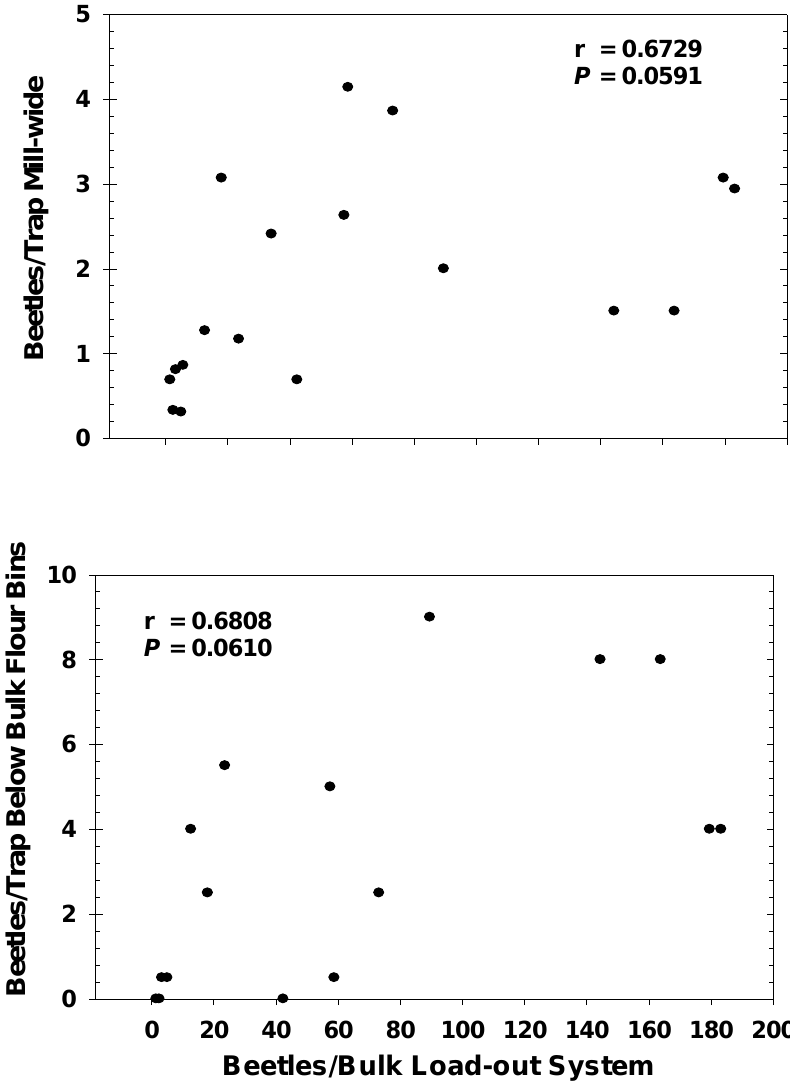
Figure 7. Correlations (r, with significance of the correlation analysis, P ) of T. castaneum trapped in mill 1 to those sampled from bulk load-out tail-overs during Year 2. Results are from 18 weekly observations from 16 modified pitfall traps (mill-wide data, top graph) and 2 modified pitfall traps (below bulk flour bins data, bottom graph). Load-out data are from six load-out systems.